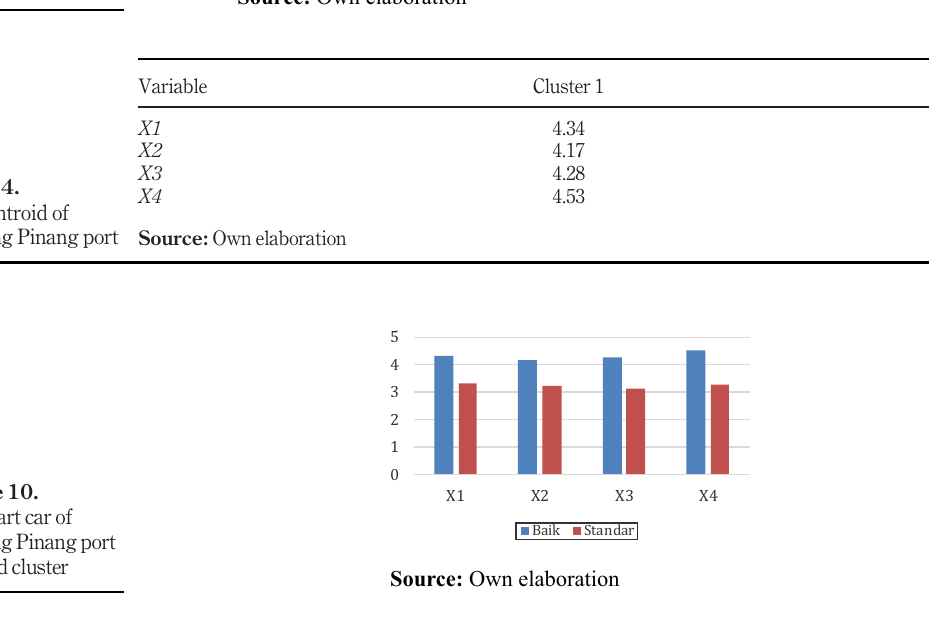
Figure 9. Scatter plot cluster of Tanjung Pinang port